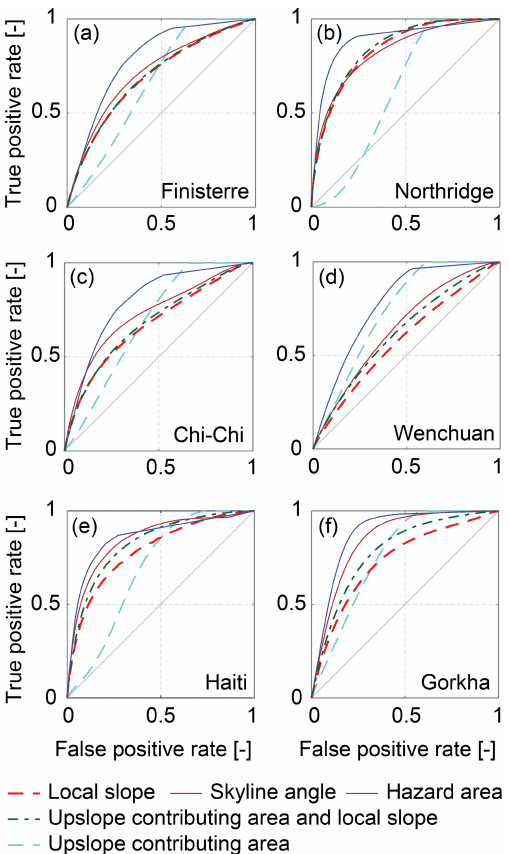
Figure 7. Receiver operating characteristic (ROC) curves for the six inventories: (a) Finisterre, (b) Northridge, (c) Chi-Chi, (d) Wenchuan, (e) Haiti and (f) Gorkha. False positive rate is given by the number of false positives divided by the sum of false pos- itives and true negatives. True positive rate is given by the num- ber of true positives divided by the sum of true positives and false negatives. The 1 : 1 line represents the naïve random case. Curves plotting closer to the top-left corner of each panel represent better model